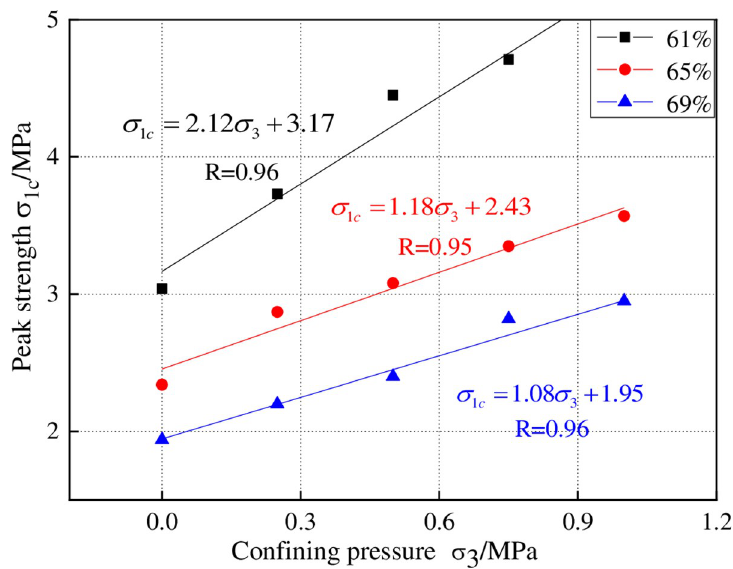
Fig 5. The curve of compressive strength versus confining